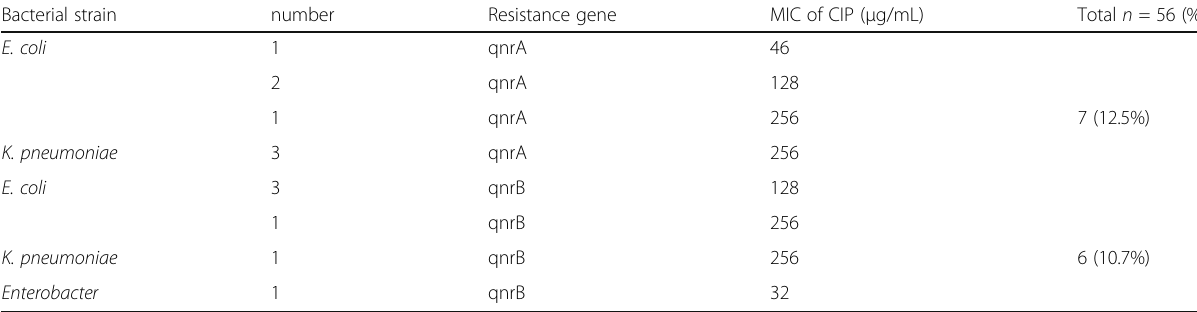
Table 3 Ciprofloxacin MICs values of qnrA- and qnrB-positive quinolone-resistant isolates Bacterial strain